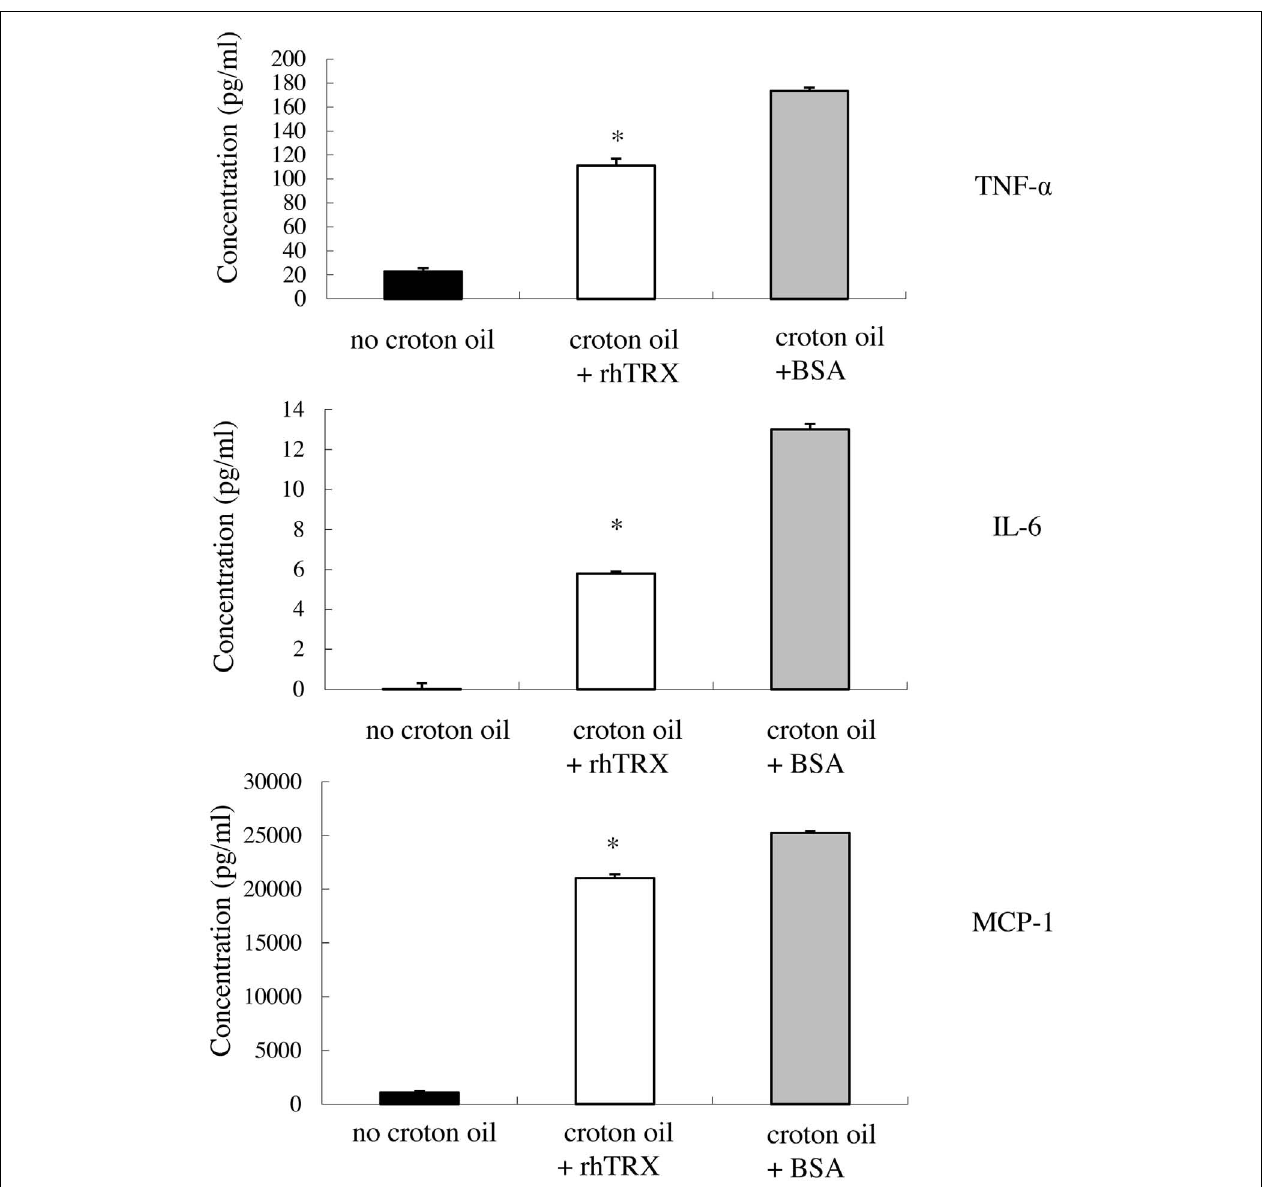
MCP-1 in the culture supernatant were measured by CBA assay 24h after croton oil treatment.The concentrations ofTNF- α , IL-6, and MCP-1 were significantly lower than those shown in the BSA application group (* P < 0.05). Values are shown as the mean ± SD of the samples (Student t